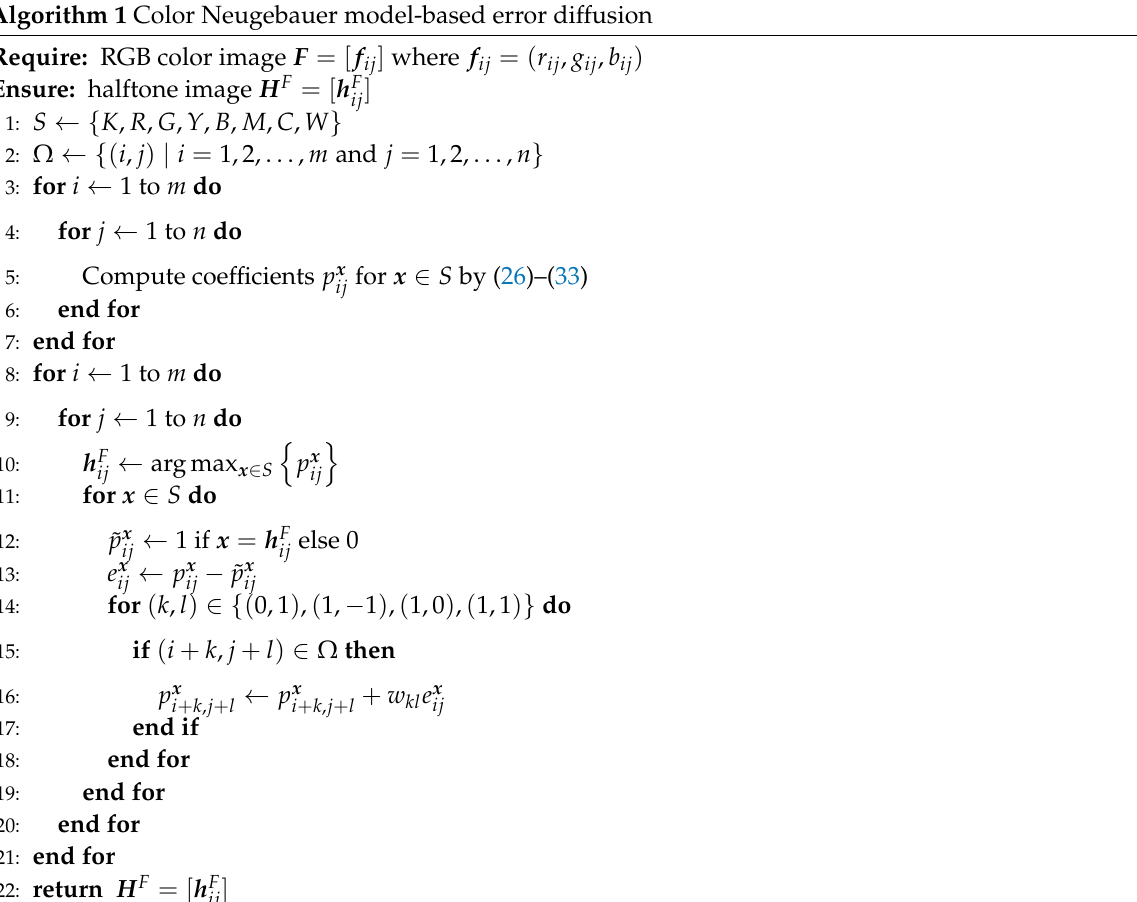
Algorithm 1 Color Neugebauer model-based error